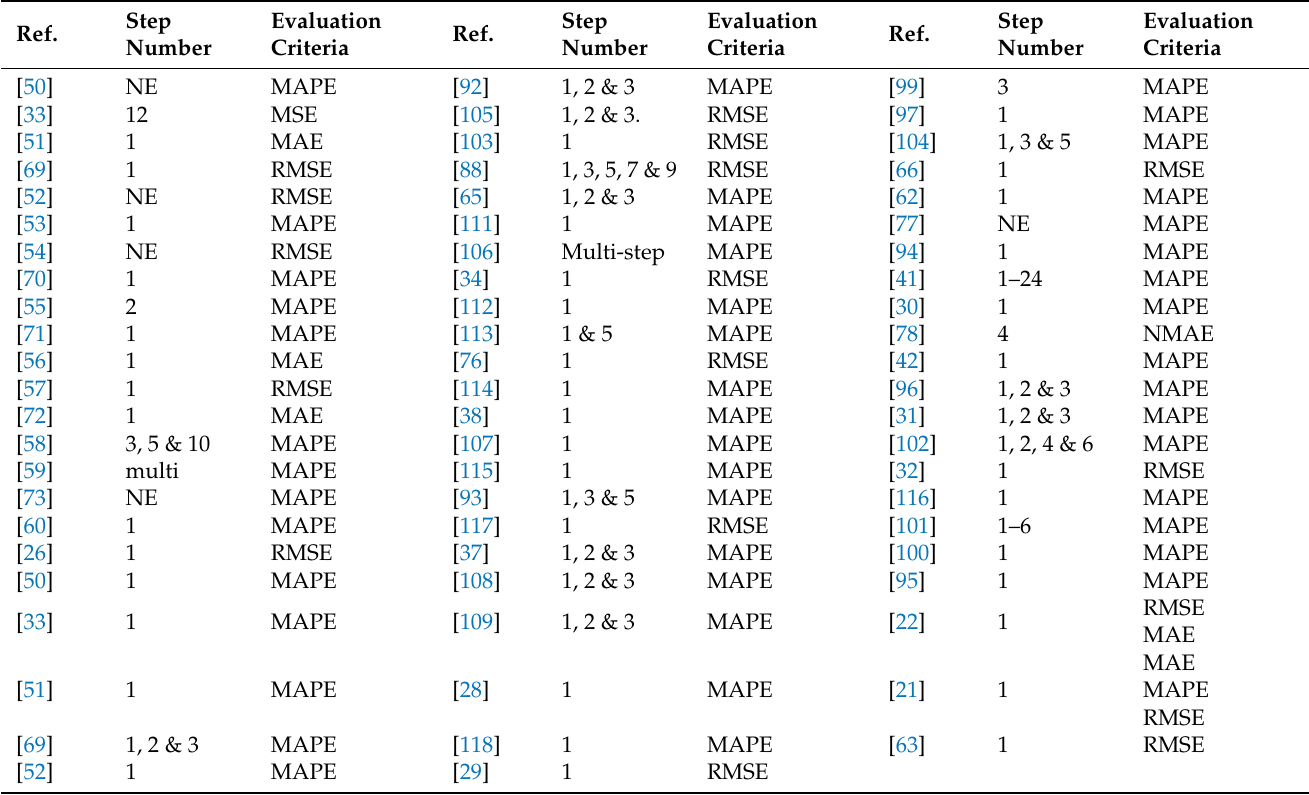
Table 3. Studies carried out with a short-term prediction horizon.